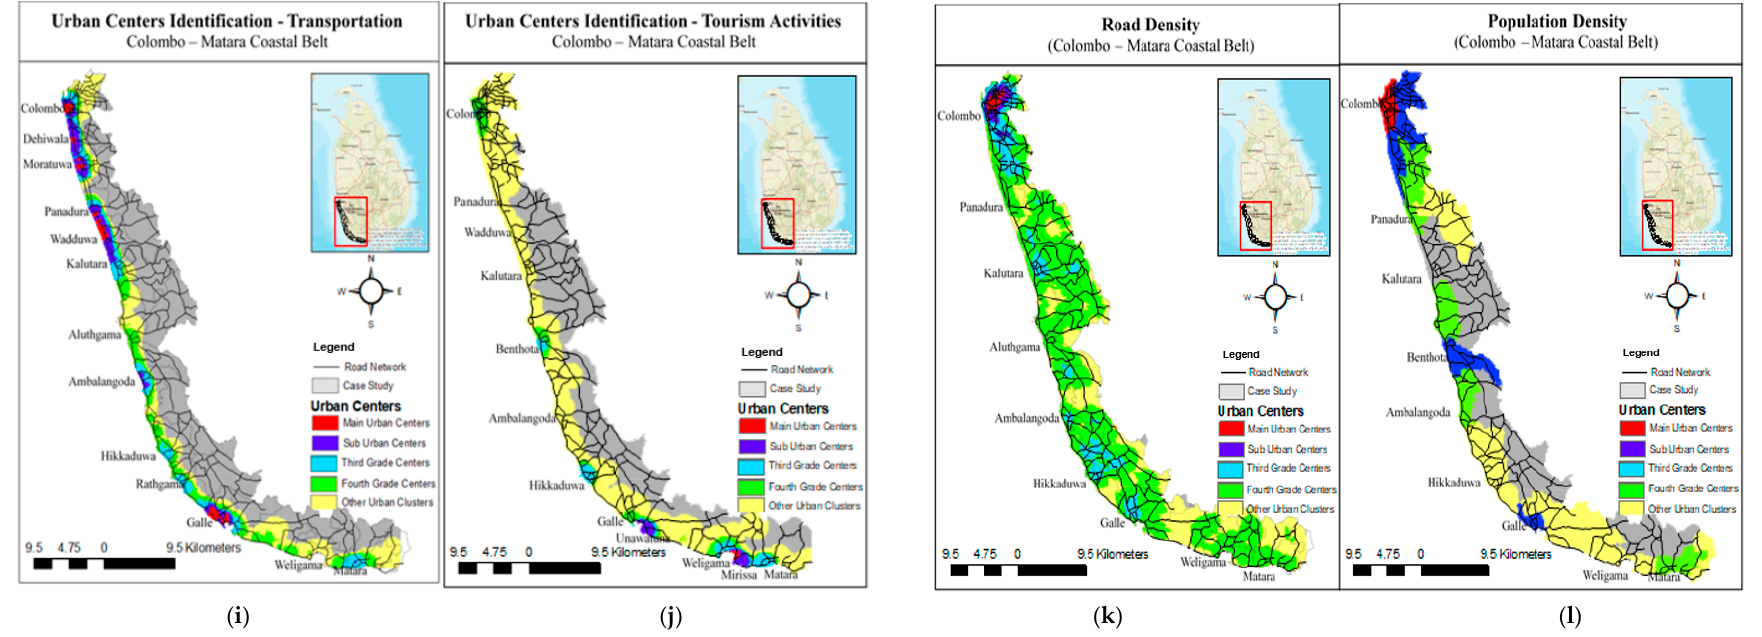
Figure 4. Urban form-related parameters: ( a ) administrative activities; ( b ) residential activities; ( c ) commercial activities; ( d ) industrial activities; ( e ) educational activities; ( f ) health activities; ( g ) banking activities; ( h ) recreational activities; ( i ) transport activities; ( j ) tourism activities; ( k ) road density; ( l ) population density.